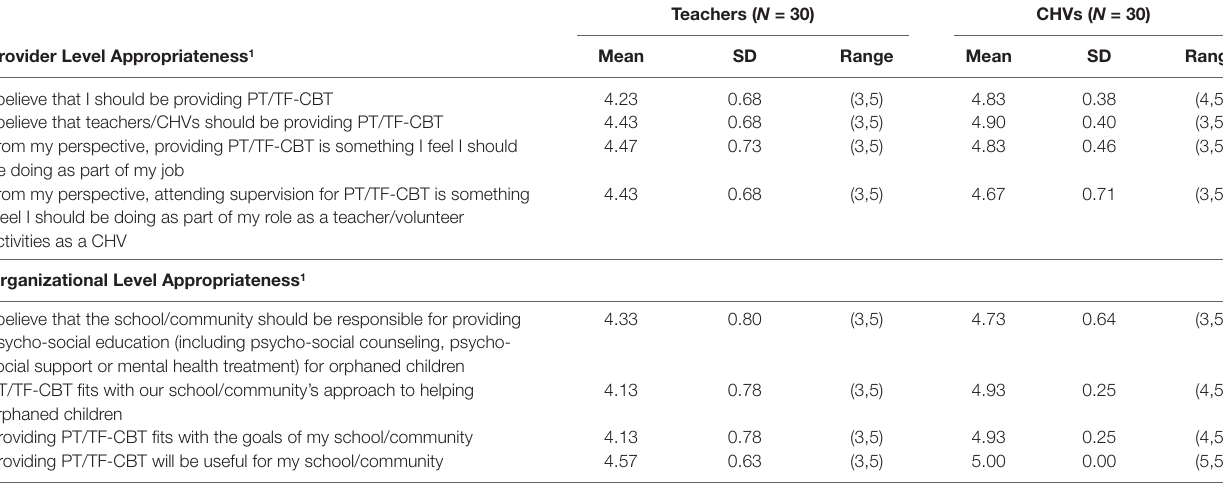
TaBLE 4 | Formative Measure of Provider and Organizational Appropriateness reported by Teachers and CHVs at